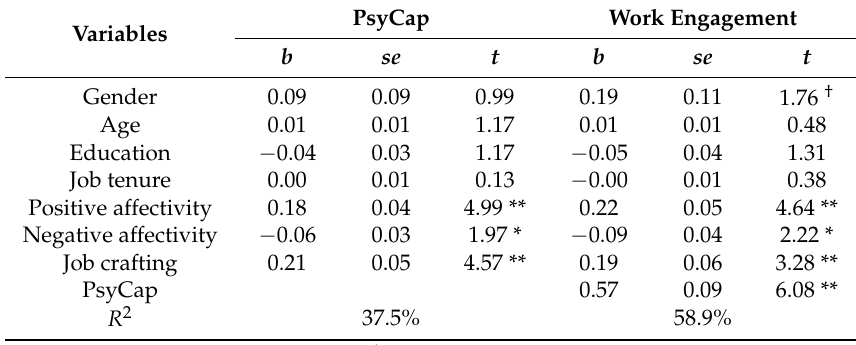
Table 2. Psychological capital (PsyCap) and work engagement regressed on job crafting.